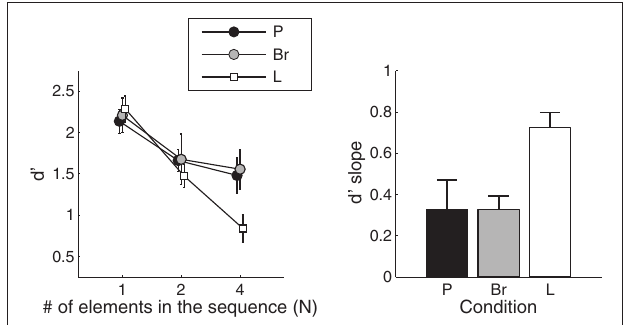
FIGURE 2 | Results for the sequence discrimination task. Left panel: the mean and standard error about the mean for the sensitivity index d (cid:48) is presented, as a function of the number of elements in the sequences and the dimension along which the elements varied (P: pitch; Br: brightness; L: loudness). Right panel: the mean values and standard error about the mean for the d (cid:48) -slope statistics. The d (cid:48) -slope represents the drop in performance between N = 1 and N = 4 in the left panel. Smaller values indicate better sequence processing.